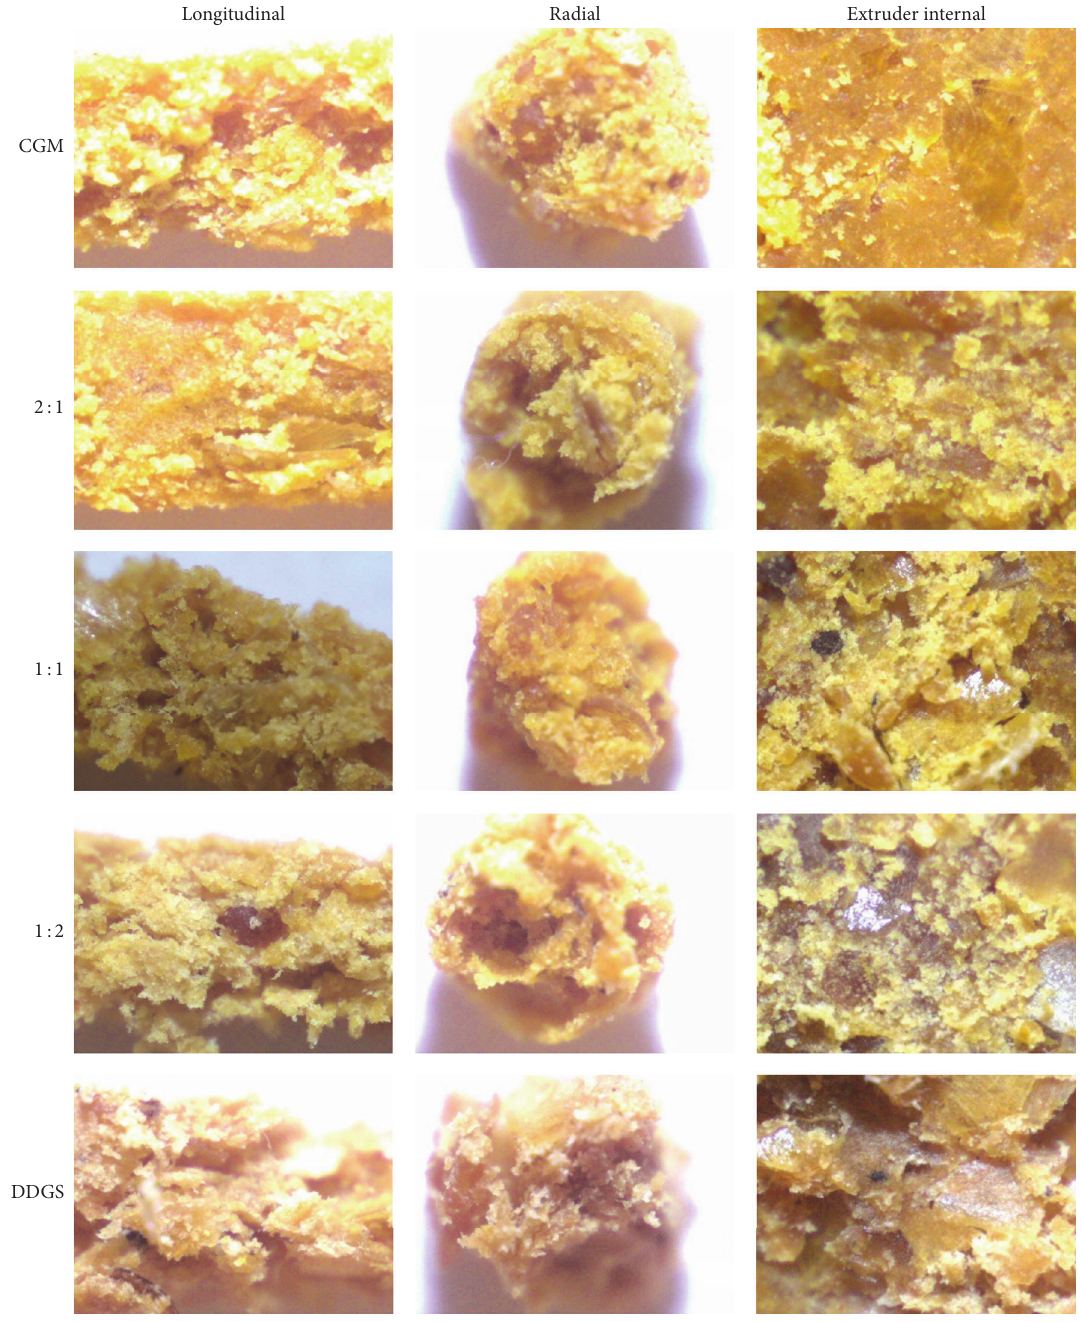
Figure 8: Optical images at × 60 magnification of CGM and DDGS and their blends in the ratios